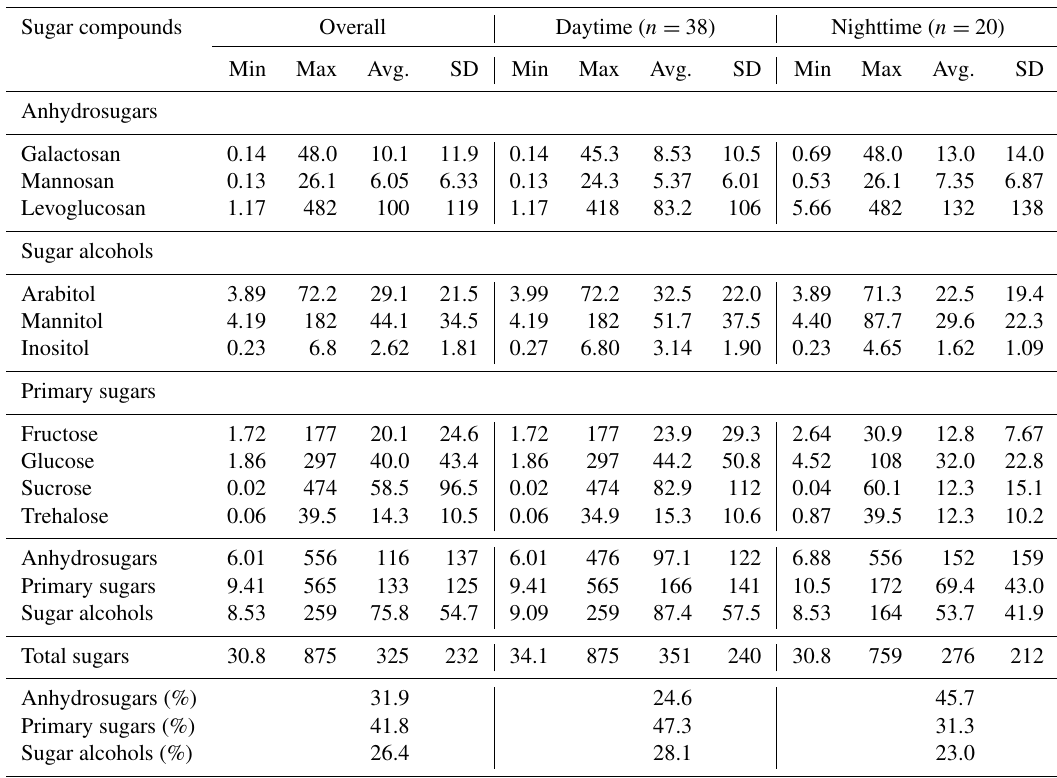
Table 1. Minimum, maximum, and average concentrations with standard deviations for sugar compounds in aerosol samples (TSP) from Mangshan, China. Sugar compounds